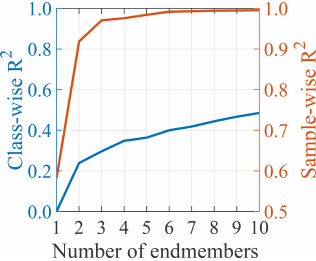
Figure A8. Median class- and sample-wise R 2 versus the number of endmembers for the ConD2d distribution dune dataset.